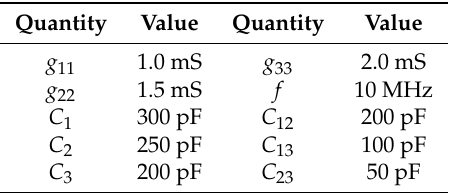
Table 2. For the circuit simulation, we consider the following values for a capacitive wireless power transfer (CWPT) system with one transmitter and two receivers. Quantity Value